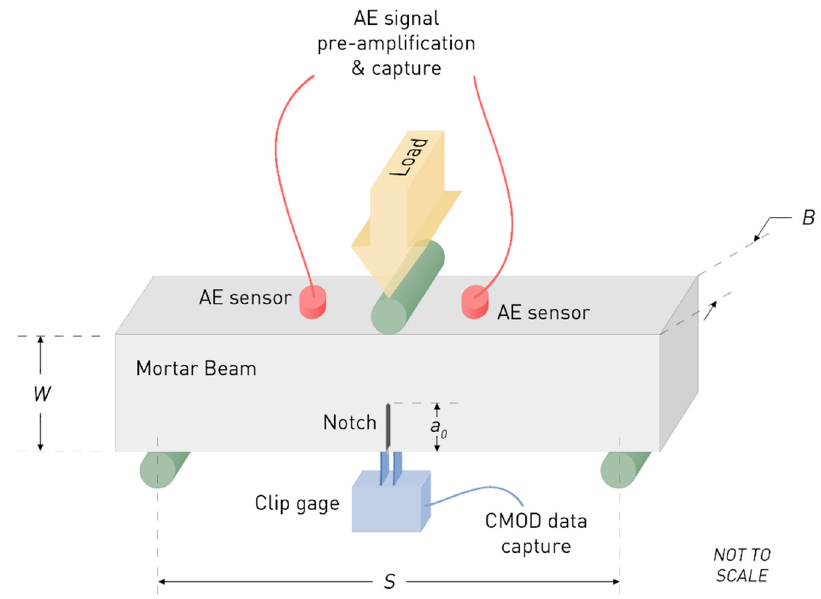
Figure 3. Three-point bend testing configuration with in situ acoustic emission monitoring.